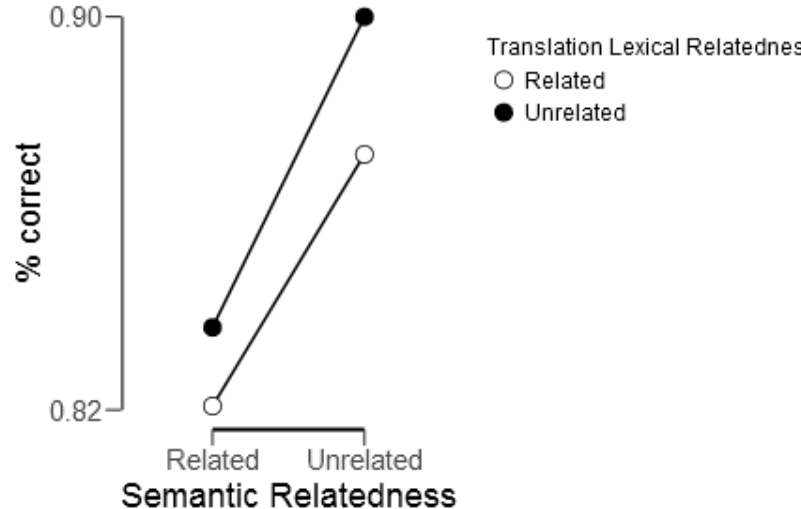
Figure 5. Accuracy main effects of semantic relatedness and L1 translation lexical relatedness.